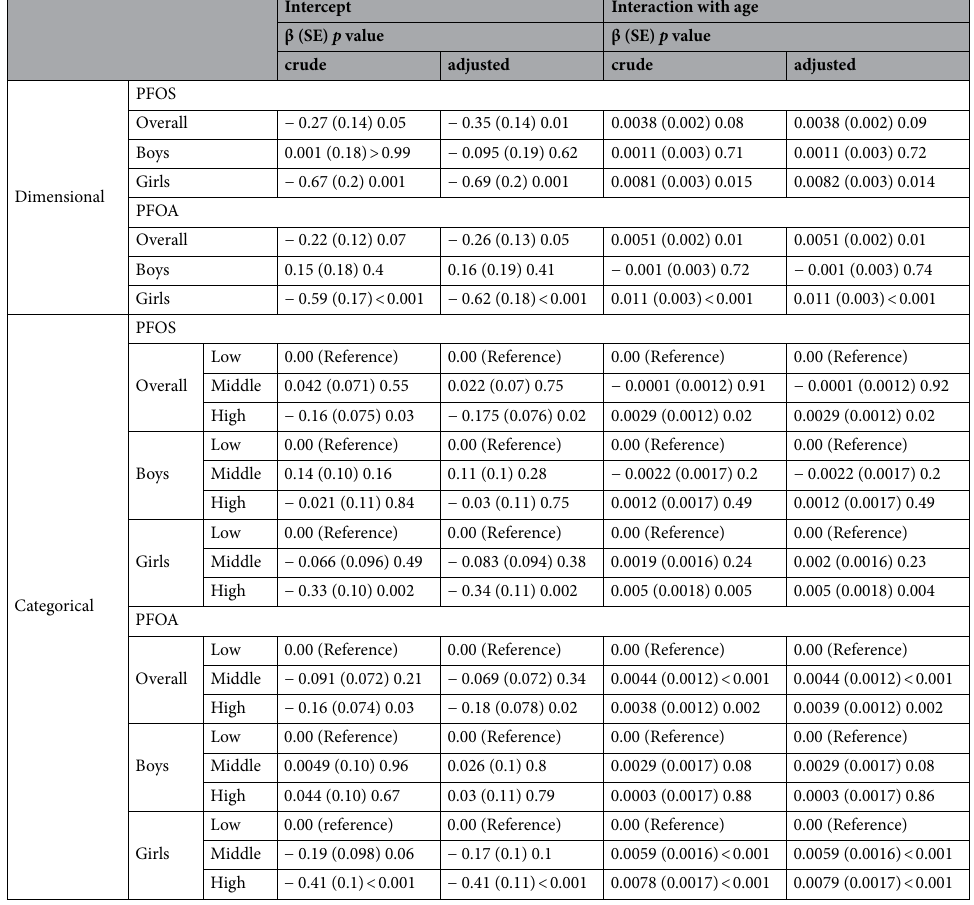
Table 3. Results of the analysis treating PFOS and PFOA concentrations as dimensional and categorical measures. Controlling covariates: maternal age at delivery, maternal BMI before pregnancy, maternal education, household income, maternal smoking during pregnancy, parity, gestational age, and duration of breast feeding. NB: SE denotes standard error, PFOS denotes perfluorooctane sulfonate, PFOA denotes perfluorooctanoic